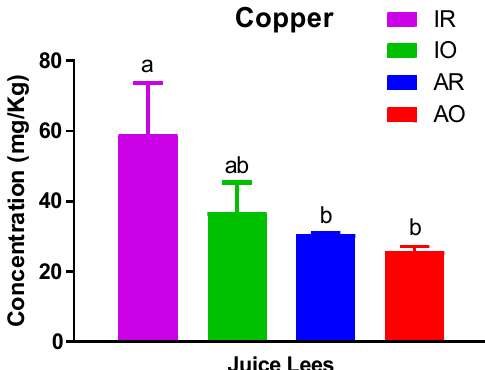
Figure 3. Effects of oxygen exposure during pressing and handling on the concentration of Cu in Chardonnay juice lees for the treatments inert pressing–reductive handling (IR, purple), inert pressing–oxidative handling (IO, green), aerobic pressing–reductive handling (AR, blue), and aerobic pressing–oxidative handling (AO, red). Significant differences between treatments are indicated by different letters above each bar graph as determined by ANOVA.